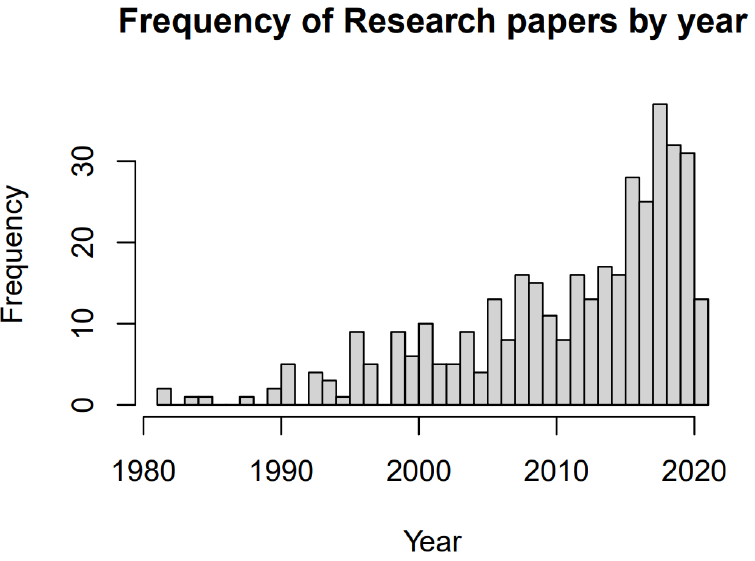
Figure 2. Frequency of publications by year a systematic map of human–raptor interaction and coexistence research. Please note that the search was conducted in April 2021, and therefore 2021 is not fully represented in the